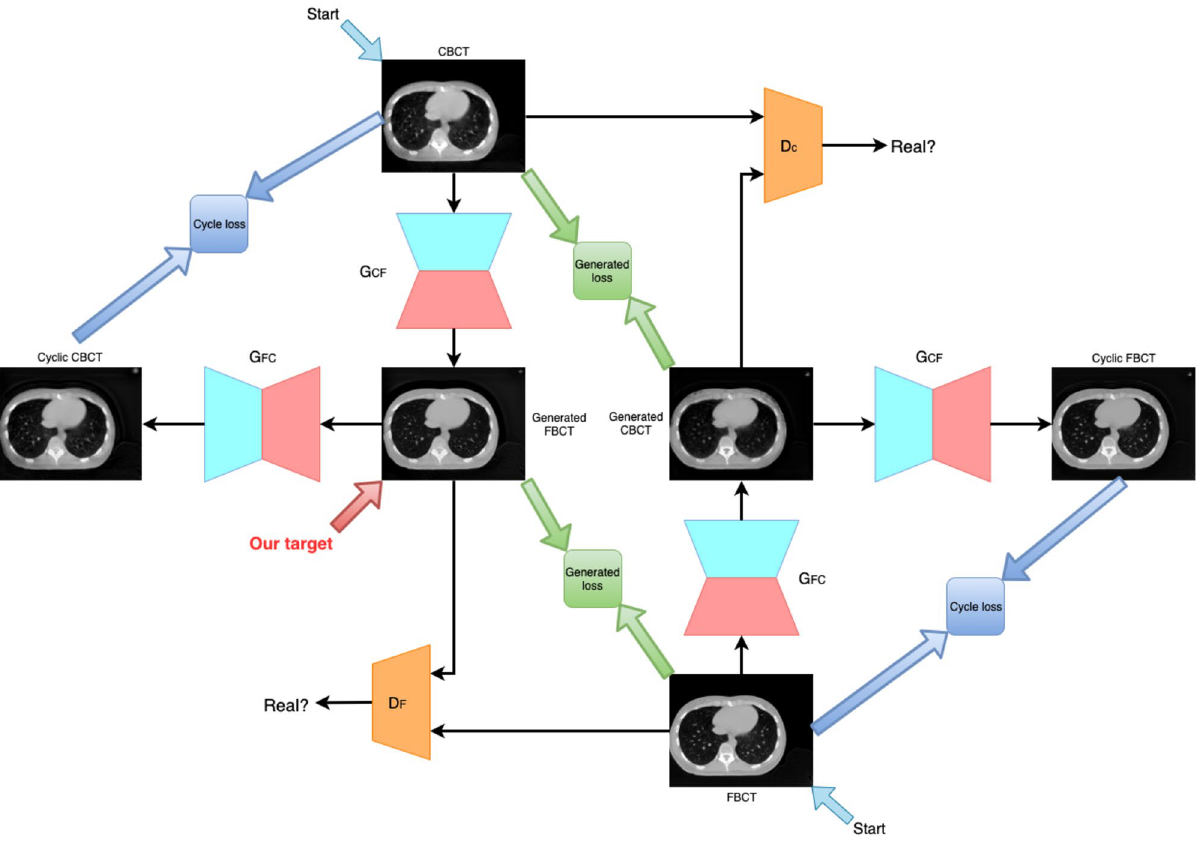
Figure 1. Architecture of Cycle-Deblur GAN.